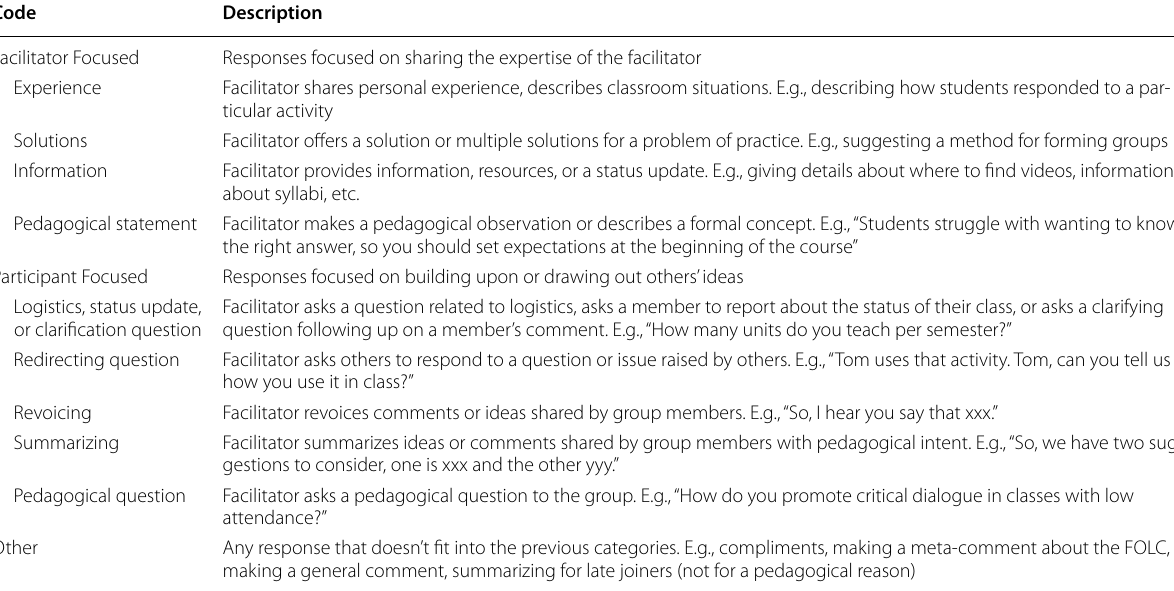
Table 4 Facilitator focused vs. participant focused coding